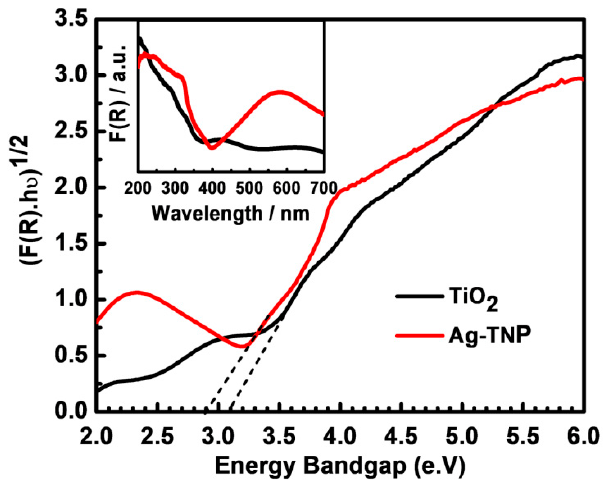
Figure 4. The diffusive reflectance analysis of as-prepared TiO 2 and Ag modified TiO 2 hybrids to obtained Tauc’s plot for an indirect bandgap model (Kubelka–Munk function). The red line belongs to Ag-TNP hybrids, and the black line belongs to unmodified TiO 2 nanoparticles. The dash-dot lines represent the tangent line towards the point, where the line intersects the horizontal energy axis (bandgap). The inset graph shows the enlarged version of the bandgap model study.